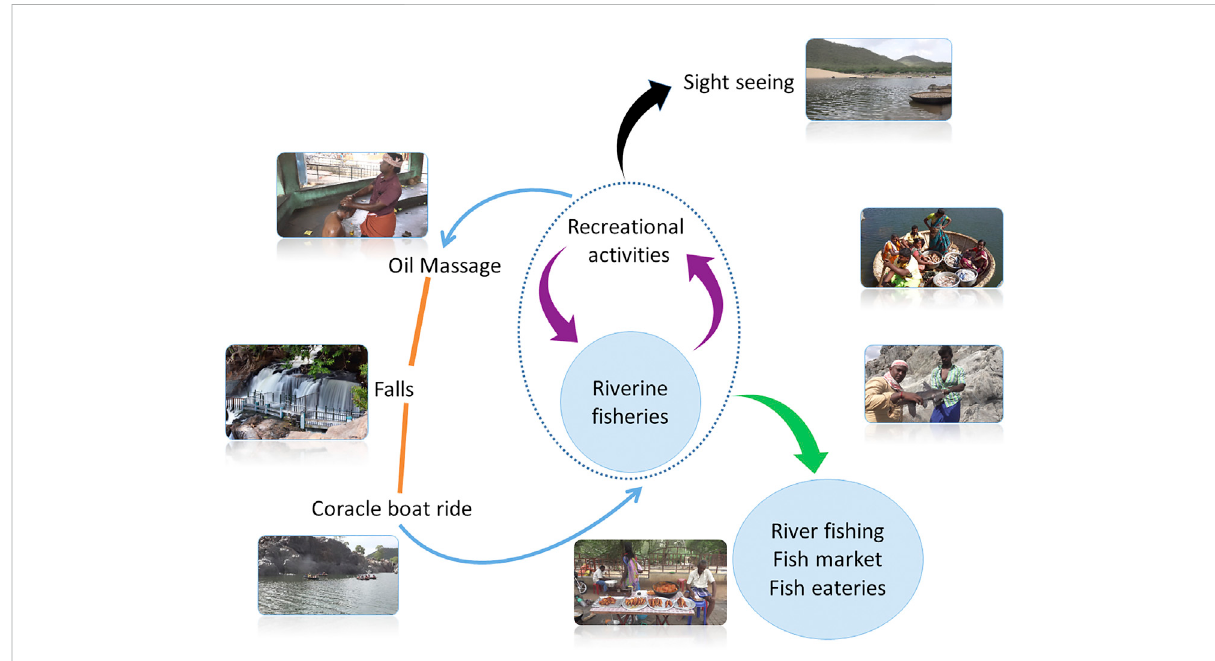
FIGURE 3 An overview of fi sheries-related activities on hogenakkal waterfall of the cauvery river, photo credit: Velumani T and V. Pownkumar.